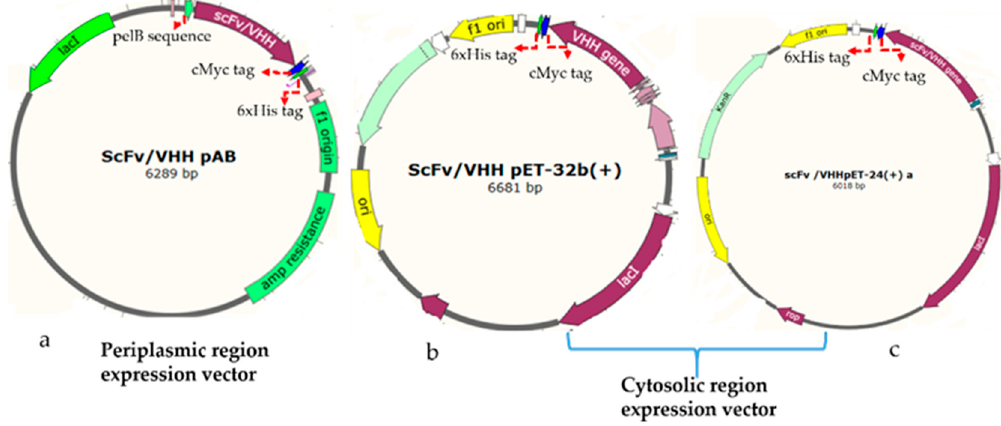
Figure 1. Schematic presentation of the antibody gene cloning vectors for the expression in the periplasmic and cytosolic compartments in the microbial system. ( a ) Design of cloning vector for the expression of the antibody fragment in the periplasmic space, ( b ) design of cloning vector for the expression of the antibody fragment in the cytosolic space with a thioredoxin tag as a chaperone protein in an oxidative cytosolic environment. ( c ) Design of cloning vector for the cytosolic space expression of the antibody fragment; the 6xHis tag and cMyc tag serve as an affinity purification tag and a signal detection tag, respectively. The plasmid DNA maps were generated using SnapGene software.